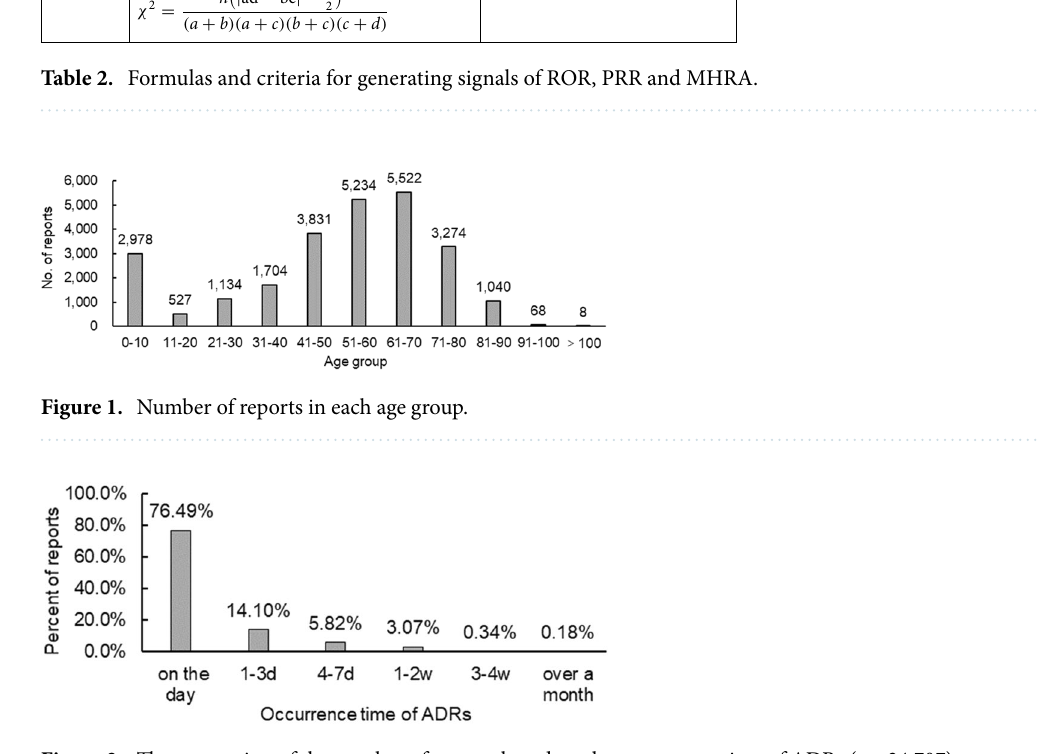
Figure 2. The proportion of the number of reports based on the occurrence time of ADRs (n =